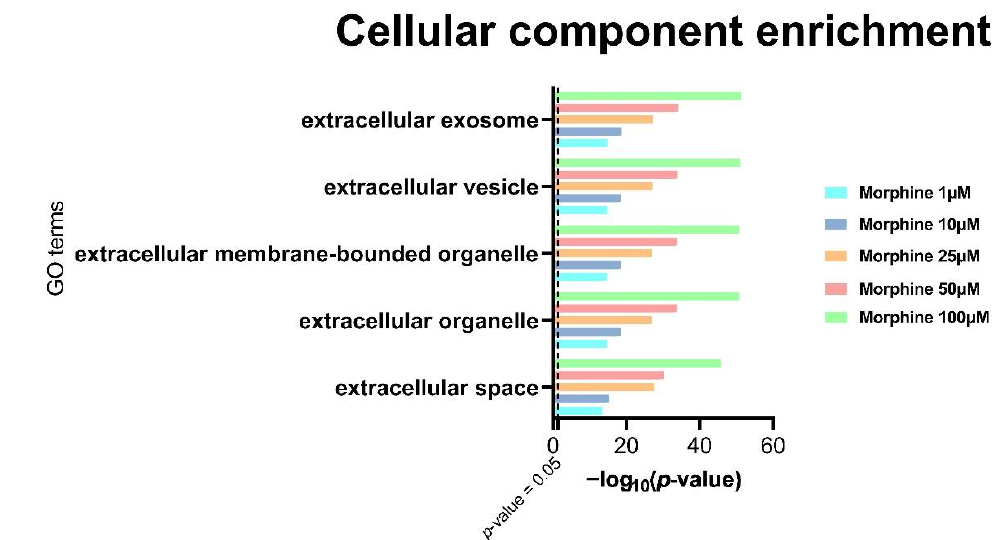
Figure 2. Characterization of extracellular vesicles isolated from human brain endothelial cells. ( a ) NTA measurement of EV sizes. Median ± SD, n = 3. ( b ) NTA measurement of EV concentration (particles/mL) of EVs. Mean ± SD, n = 3. (c) Western blots of EVs isolated by EVTRAP beads and brain endothelial cells lysate (cells). Alix, TSG101 and CD9 represent common EV markers. Calreticulin is an EV negative control, n = 3. ( d ) Mass spectrometry protein abundances of EV markers Alix and CD9. Mean ± SD, n = 3. ( e ) Gene Ontology term enrichment of EV quantified proteins provided by MetaCore™ software. X-axis corresponds to − log 10 ( p -value), Y-axis corresponds to the gene ontology terms and the dot line represents the p -value cut-off of 0.05.